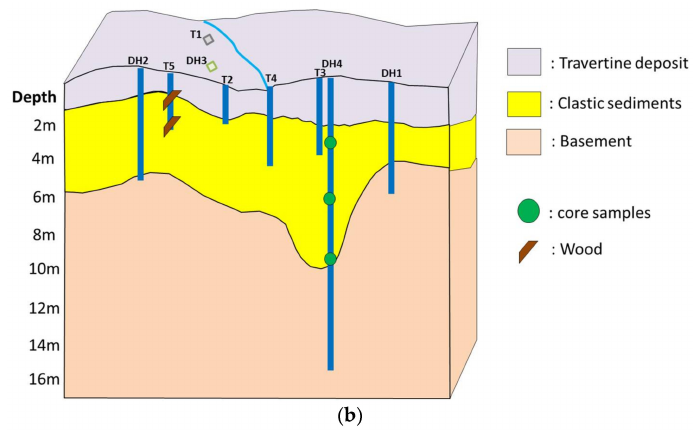
Figure 2. ( a ) Overhead photo of the main sampling site; ( b ) Cross-sectional view of